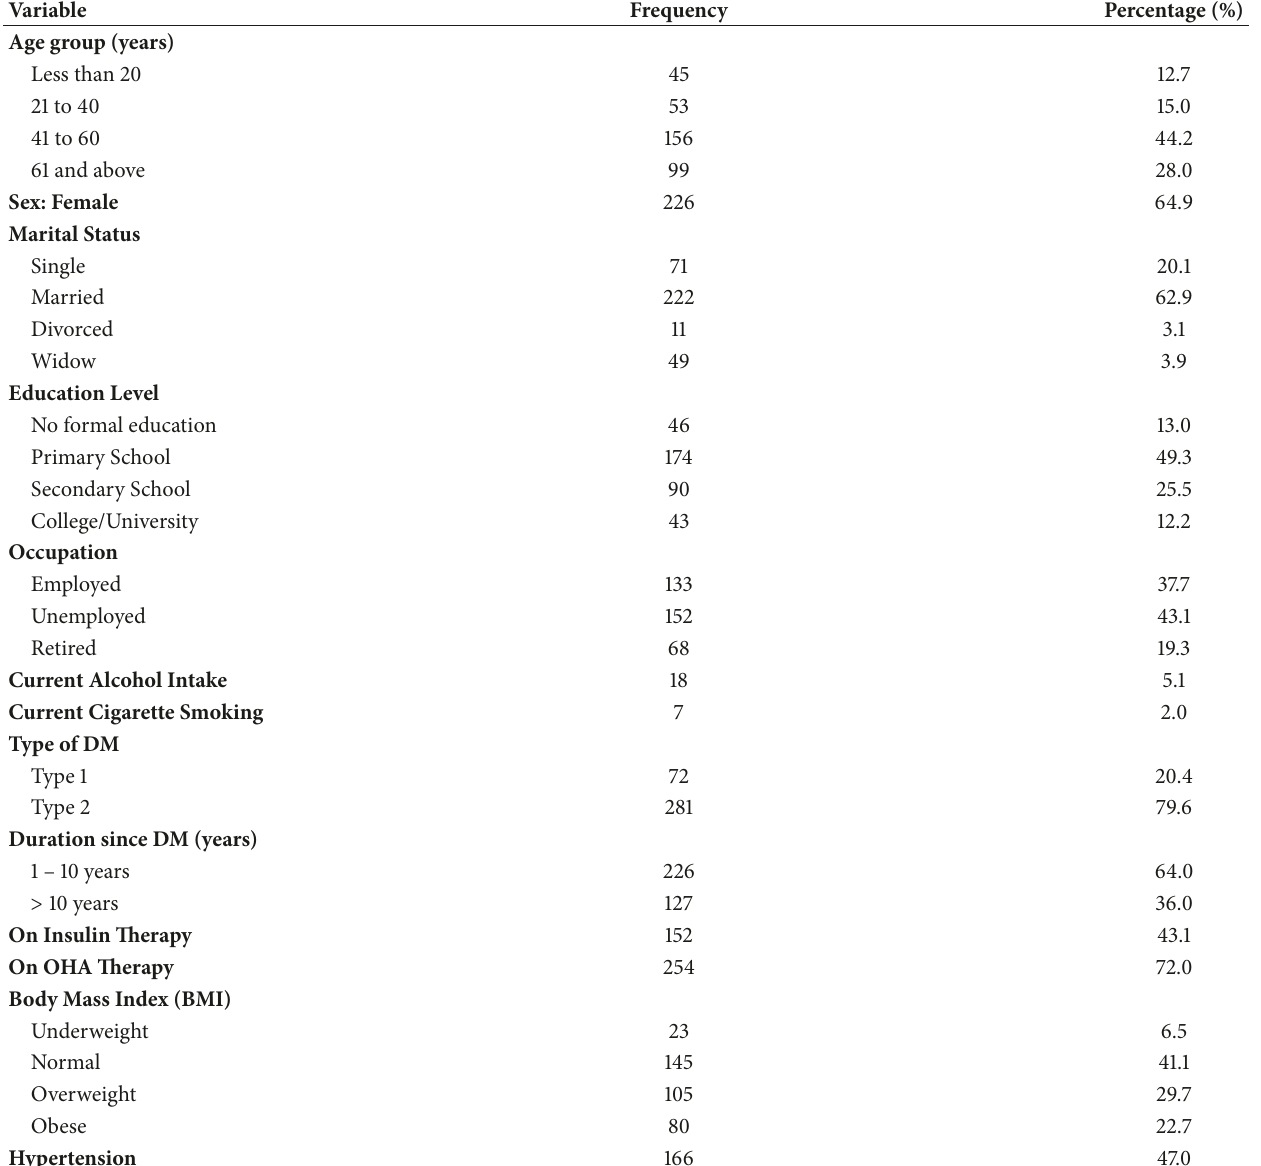
Table 1: Demographic and clinical characteristics of the study population (N =